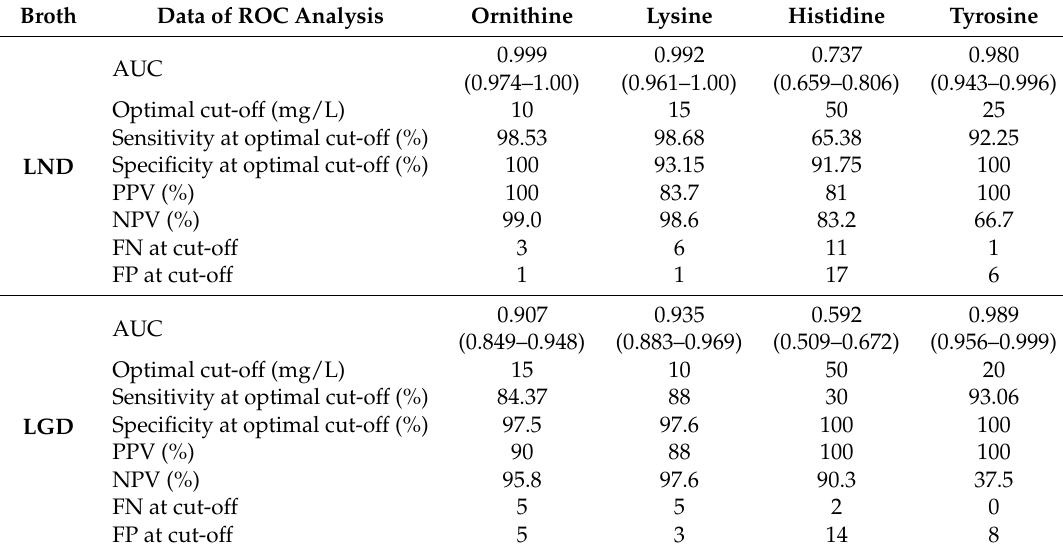
Table 2. Receiver Operating Characteristic (ROC) curve analysis of qualitative method to predict specific amino acid decarboxylase activity in isolates using Low Nitrogen Decarboxylase (LND) and Low Glucose Decarboxylase (LGD)